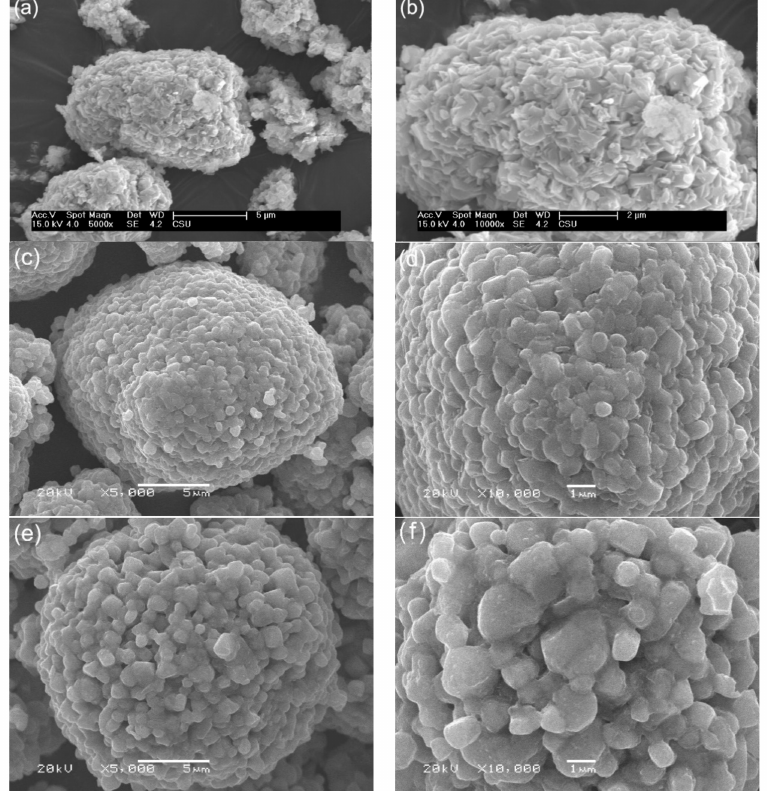
Figure 1. SEM images of the Ni 1/3 Co 1/3 Mn 1/3 (OH) 2 precursor and the synthesized LiNi 1/3 Co 1/3 Mn 1/3 O 2 compounds: ( a , b ) Ni 1/3 Co 1/3 Mn 1/3 (OH) 2 precursor; ( c , d ) Pristine LNCM; ( e , f ) Cl&Br co-doped